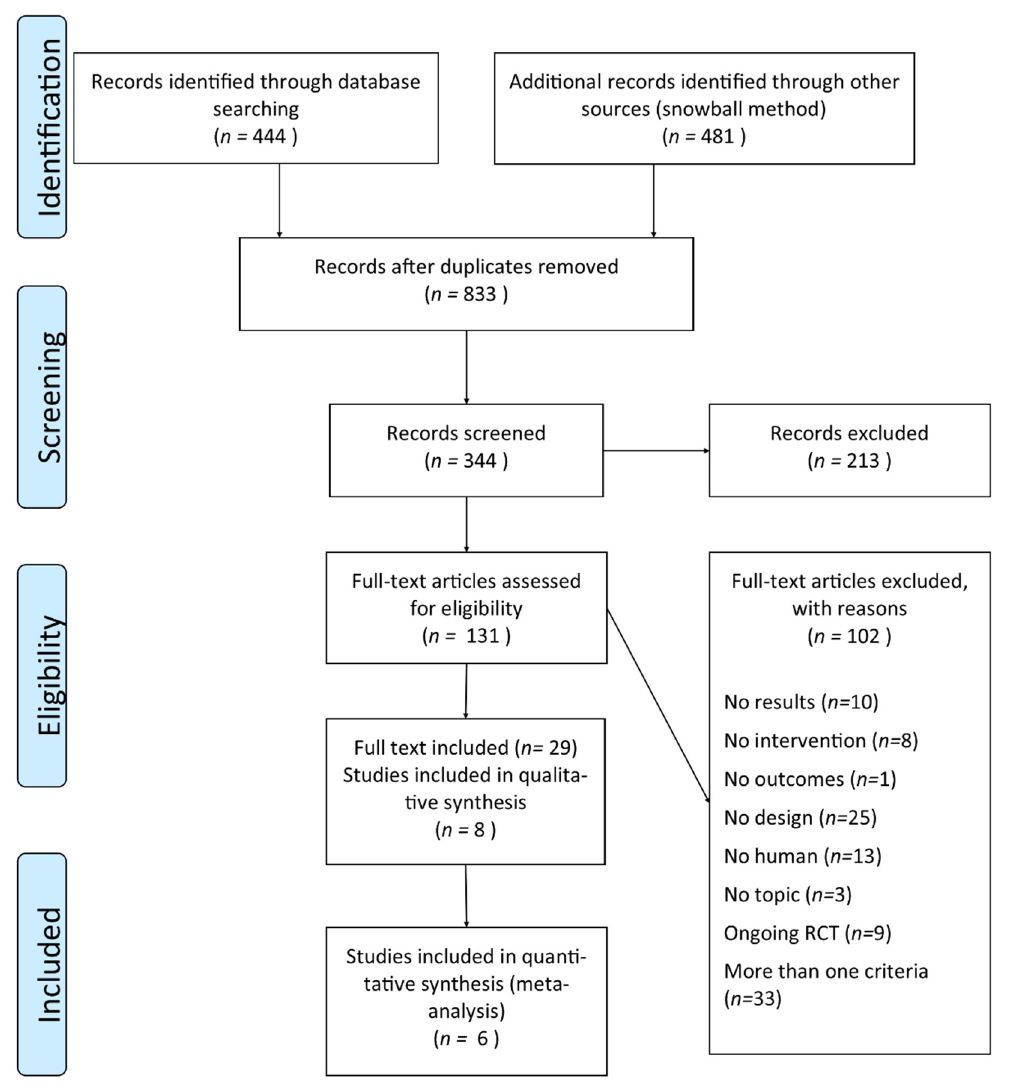
Figure 1. Preferred Reporting Items for Systematic Reviews and Meta-Analyses (PRISMA) flow diagram of the study.